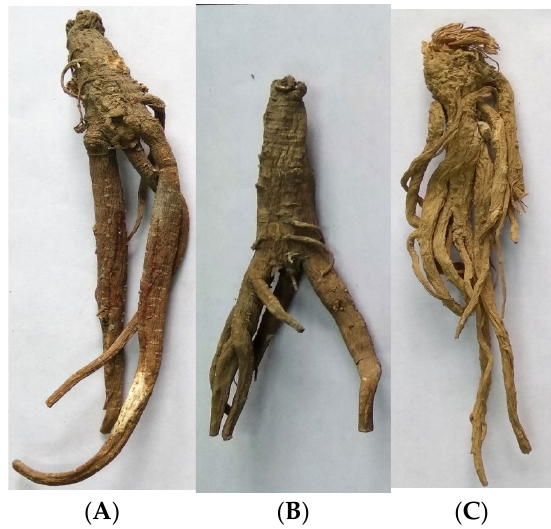
Figure 7. Morphological features of RVT-1 ( A ), RVT-2 ( B ), and RAS ( C ).